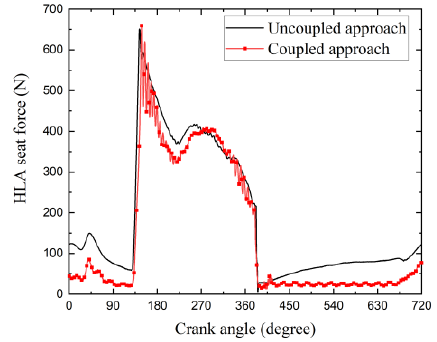
Figure 24. The HLA seat force comparison between the two approaches.